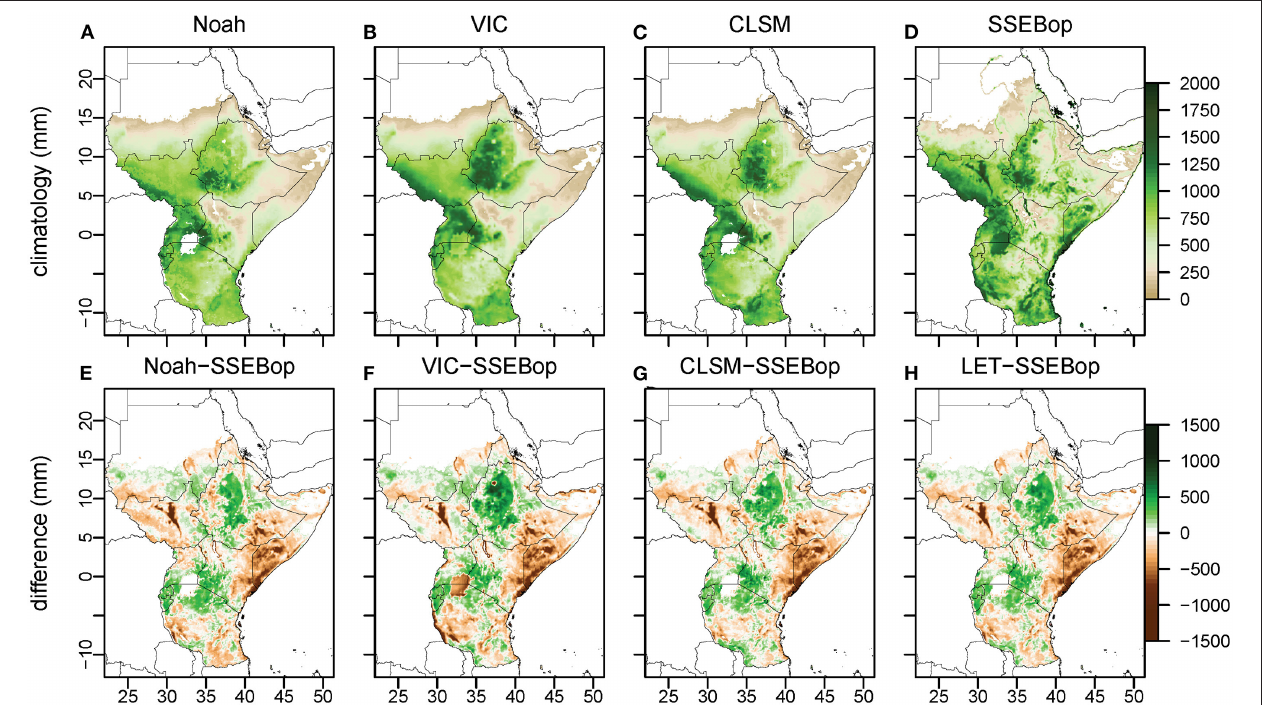
FIGURE 2 | Annual total evapotranspiration (ET; in mm) for the period 2003–2016 from (A) Noah, (B) VIC, (C) CLSM, (D) SSEBop. The bottom row shows the difference in ET climatology between (E) Noah minus SSEBop, (F) VIC minus SSEBop, (G) CLSM minus SSEBop, and (H) ensemble mean of Noah, VIC, and CLSM minus